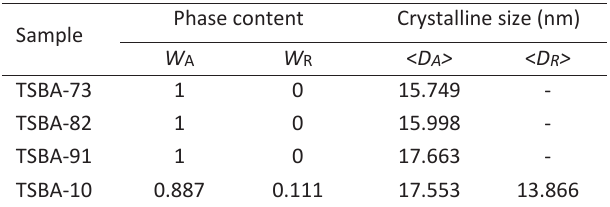
Table 1 - Anatase (W A ), and rutile (W ) phase content in differ- R ent TiO 2 /SiO 2 samples and their corresponding crys- talline sizes calculated from XRD data